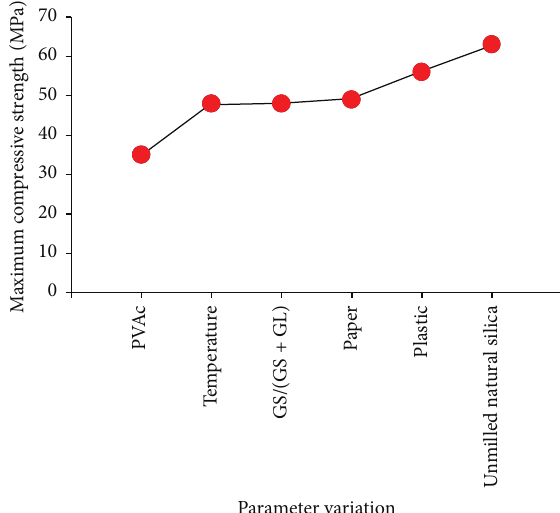
Figure 10: The maximum compressive strength obtained from the sequential variation of parameters. The direction of the variation in parameters is from left to right. Unmilled natural silica is rice husk that has not undergone the milling process.